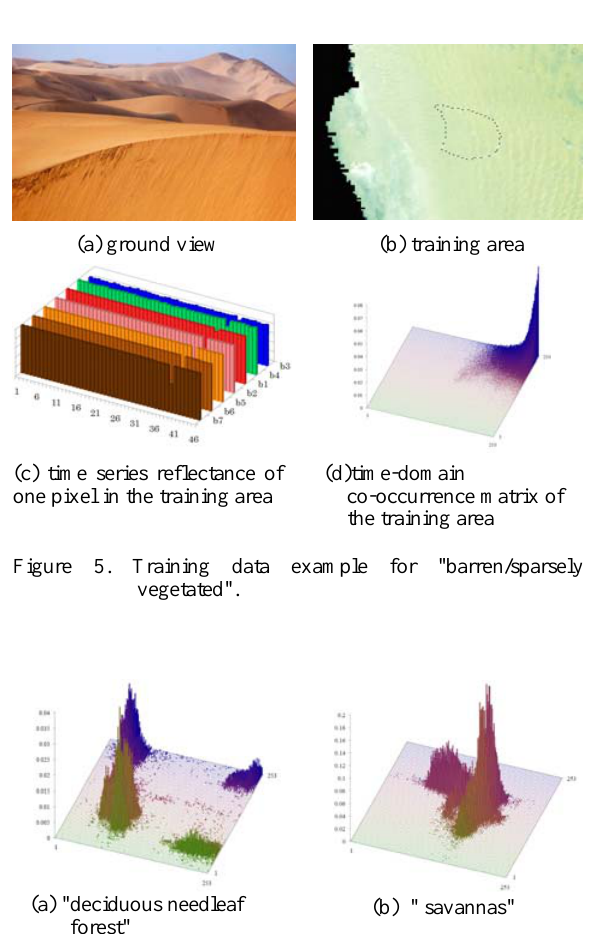
Figure 6. Examples of obtained time-domain co-occurrence matrix.